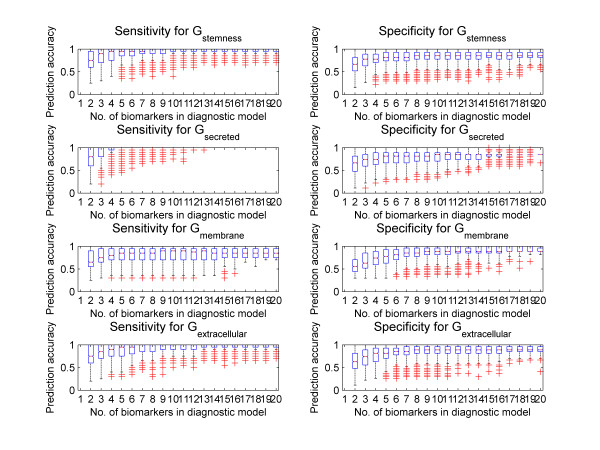
Prediction accuracy. Box plots of the accuracy (sensitivity or specificity) of the prediction of the differentiation state of embryonic stem cells using "n" (2 to 20) mRNA transcript levels as diagnostic signature patterns. The box has lines at the lower quartile (25th), median (50th), and upper (75th) quartile values. The whiskers are lines extending 1.5 × (inter-quartile ranges) from each end of the box with outliers ('+') marked. The box plot shows the average prediction accuracy (based on 500 random divisions of the sample set into training and test sub-sets) for the 30,000 diagnostic models created for each "n". The diagnostic models were built using Gstemness (size = 114), Gsecreted proteins (size = 21), Gmembrane proteins (size = 25) and Gextracellular proteins (size = 46) separately. Extracellular proteins include secreted and membrane proteins.